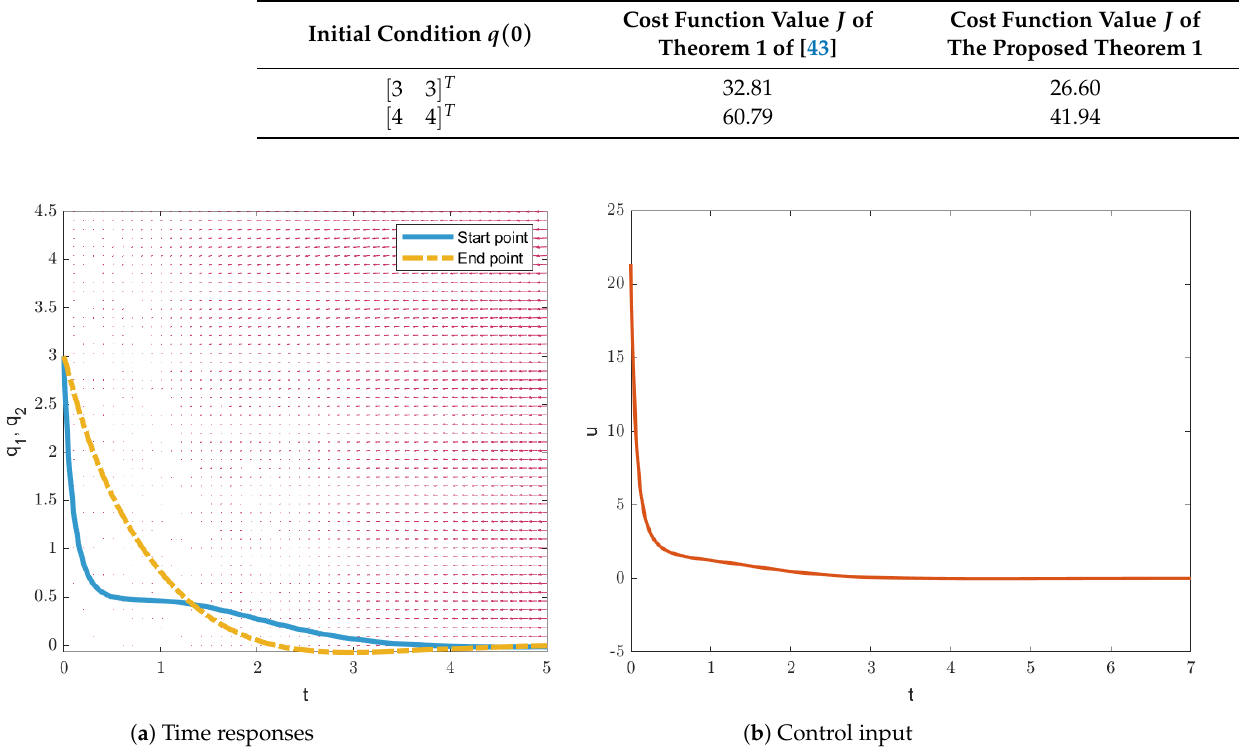
Figure 1. The time responses and the control input of the proposed guaranteed cost controller for the initial condition q ( 0 ) = [ 3 3 ] T in Example 1.